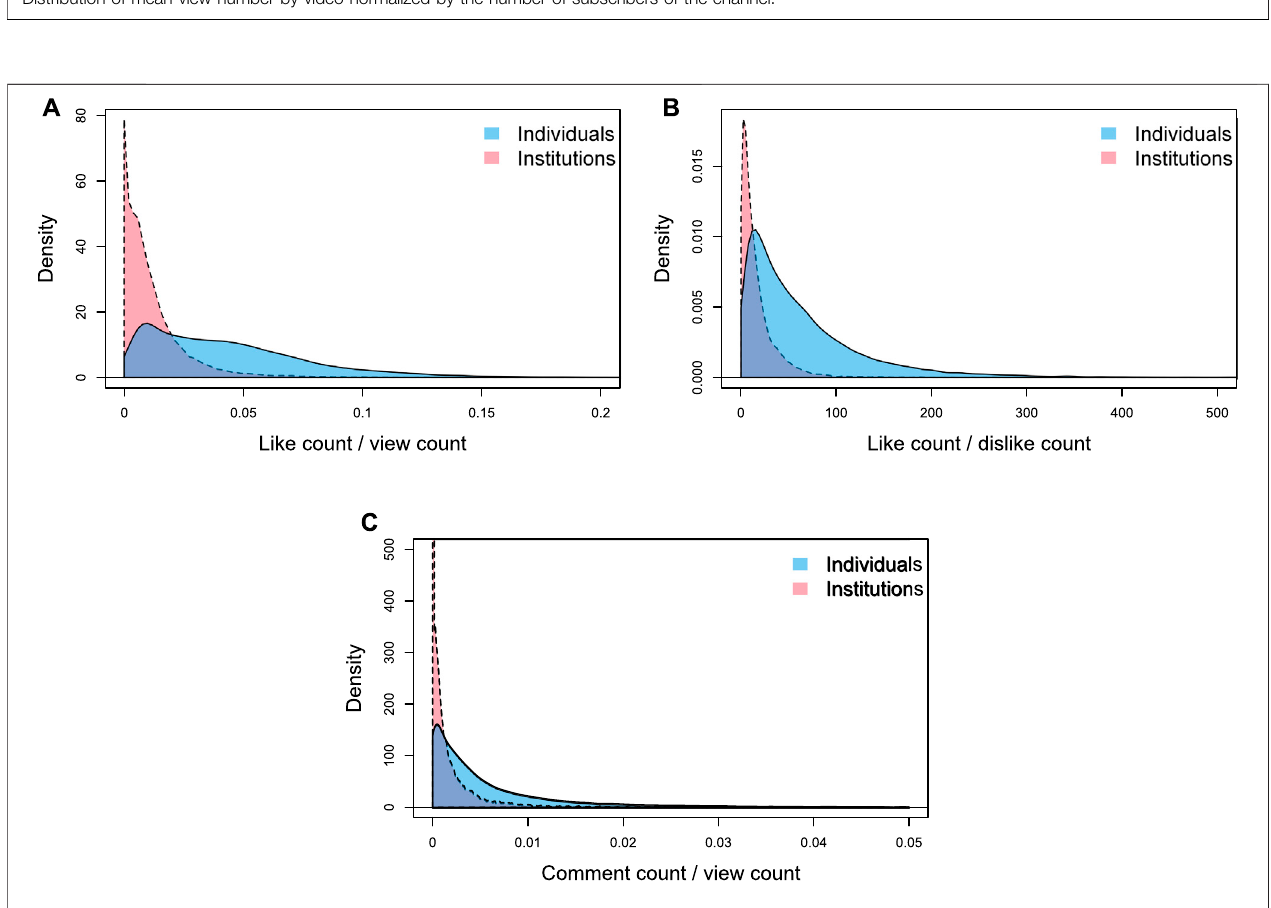
FIGURE 8 | Differences of viewer engagement between channels run by institutions and individuals. (A) Distribution of the number of likes per view (B) Distribution of the ratio of likes vs dislikes (C) Distribution of the number of comments posted per view.